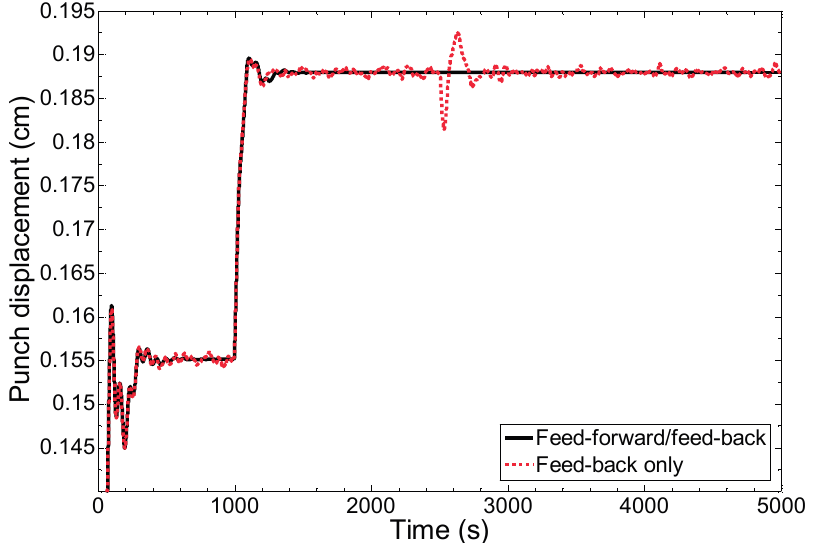
Figure 6. Comparison of actuators obtained from combined feed-forward/feed-back control strategy with feed-back only control strategy for hardness